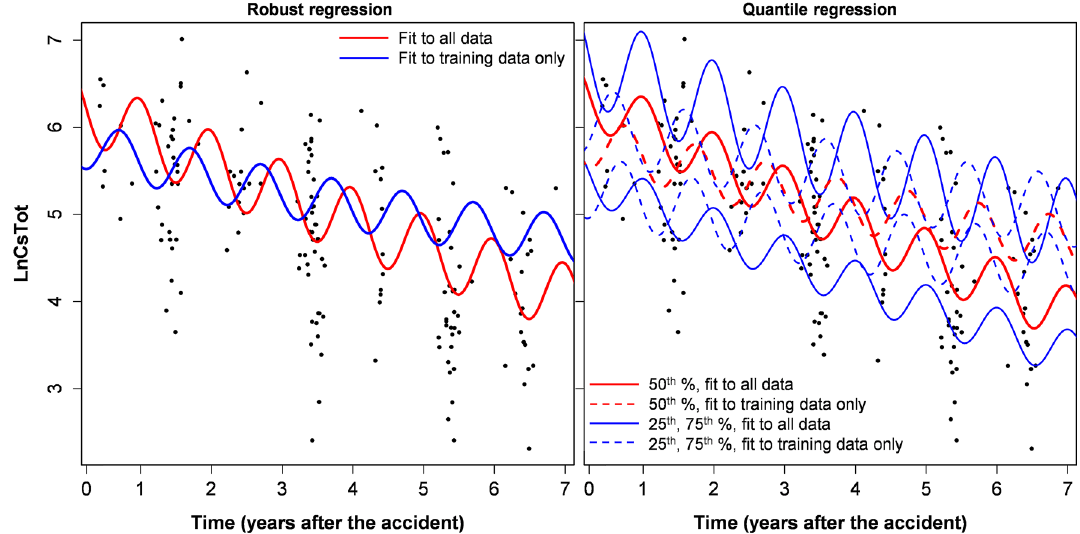
Figure 4. Robust and quantile regression analyses for Asian black bear ( Ursus thibetanus ) data for specific locations (Kenpoku and Kenchu districts) with high average radioactive cesium levels. This figure was generated using R 4.0.3 software 21 .